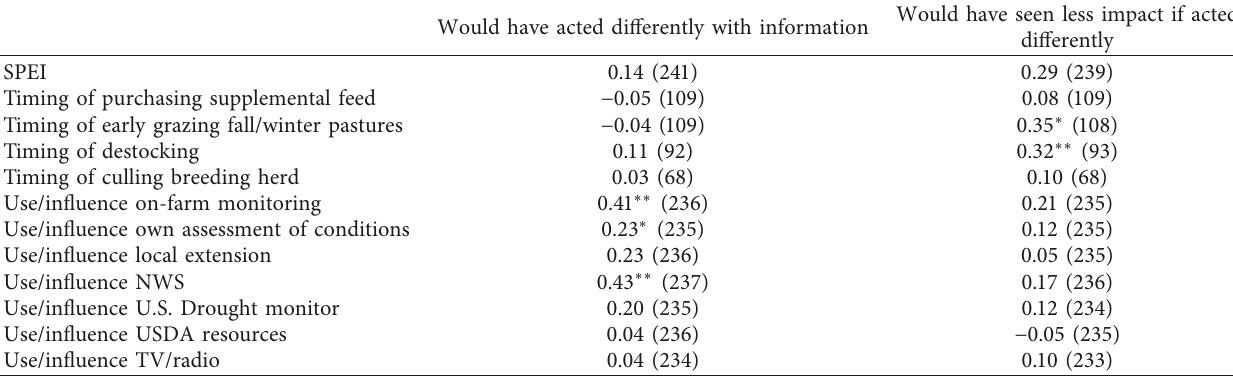
Table 5: Factors affecting perceived capacity to improve drought